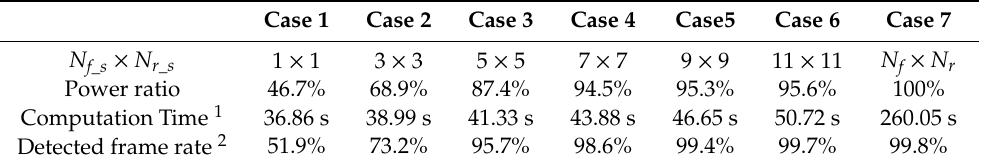
f th e proposed filter with different sizes of sub-area. Table 2. Performance of the proposed filter with di ff erent sizes of sub-area. Table 2. Performance o